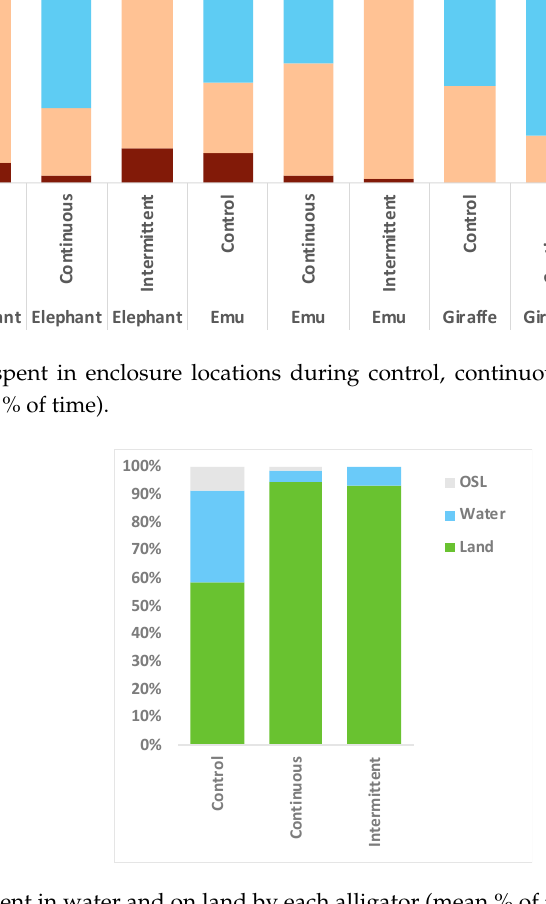
Figure 9. Time spent in proximity to the nearest conspecific during control, continuous, and intermittent sound conditions (mean % of time). 3.4. Emu Fecal Corticosterone Individual fecal corticosterone metabolite concentrations are shown for emus Elvis and Matilda in Figure 10. Concentrations ranged from 11.6 to 374.7 ng/g in control samples from Elvis and from